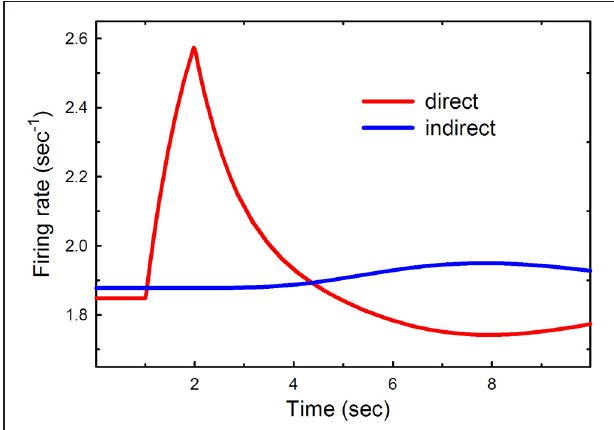
FIGURE 2 | Phasic cortical input to the direct pathway. The cortical input to the direct pathway, a 2 , was doubled between t = 1s and t = 2s. The red and blue curves show the firing rates as a function of time in the direct and indirect pathways,